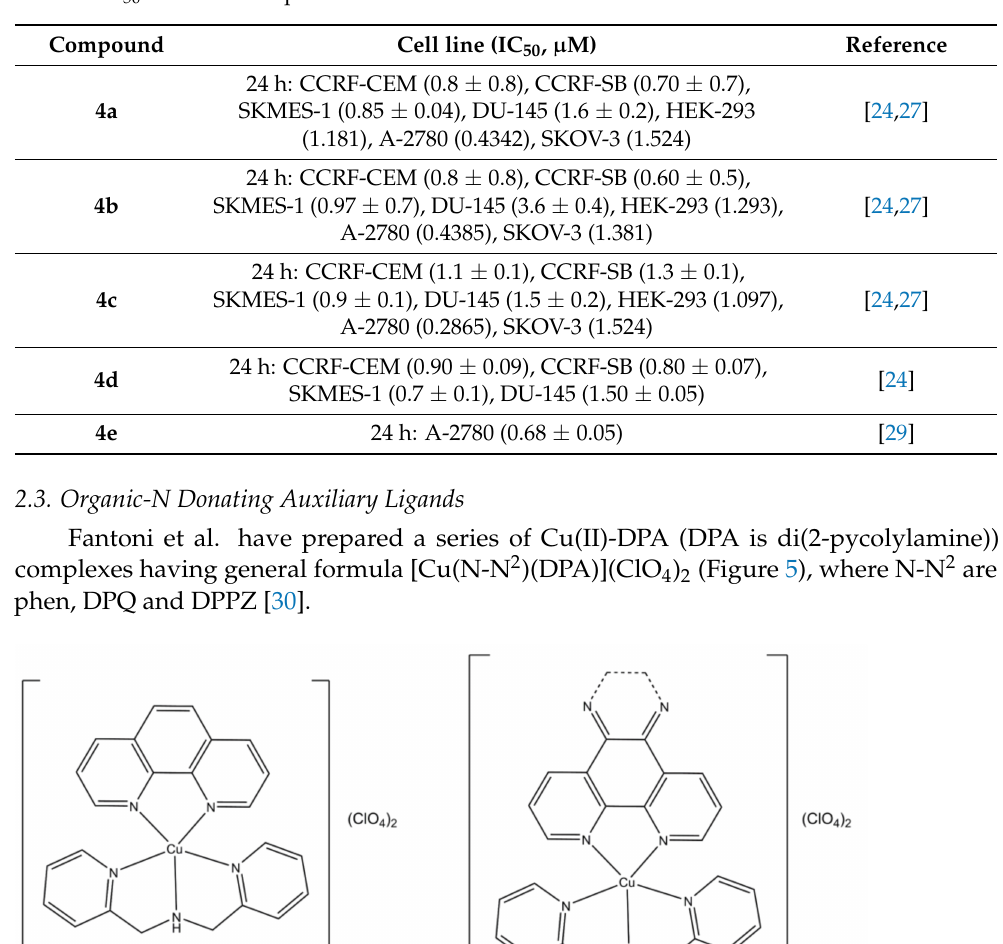
Table 2. IC 50 values of compounds 4a – 4e .